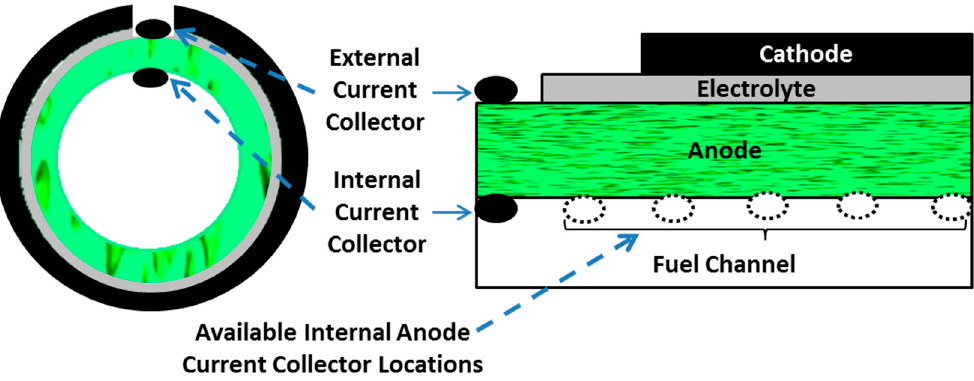
Figure 6. Cross-sectional schematic of internal and external current collection in an anode-supported µT-SOFC with available internal anode current collector locations (not to scale).